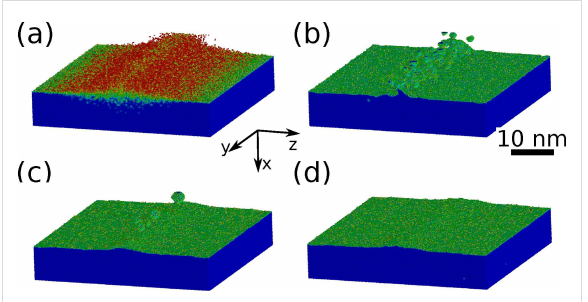
Figure 5: Simulation of the formation of a single row of Si NCs by line irradiation. The sample is composed of bulk silicon with a 7 nm thick oxide layer and a 20 nm top silicon layer. The lateral size of the computational cell is 55 nm in both lateral direction ( y , z ), with periodic boundary conditions in both lateral directions. (a) Si mixed into SiO 2 by a focused Ne + beam (4 nm beam diameter, 5 nm line width, 2000 Ne + nm − 2 , 25 keV). The color code corresponds to the binding state of the Si atoms. Blue: Si in the bulk; green: Si at an interface; red: individual Si atoms in an oxide matrix. (b–d) Snapshots from the kMC- based annealing simulation at 1273 K showing the formation ((b) 300 MCs, (c) 3000 MCs), and dissolution ((d) 10000 MCs) of the individual Si NC. The top silicon layer is not shown for